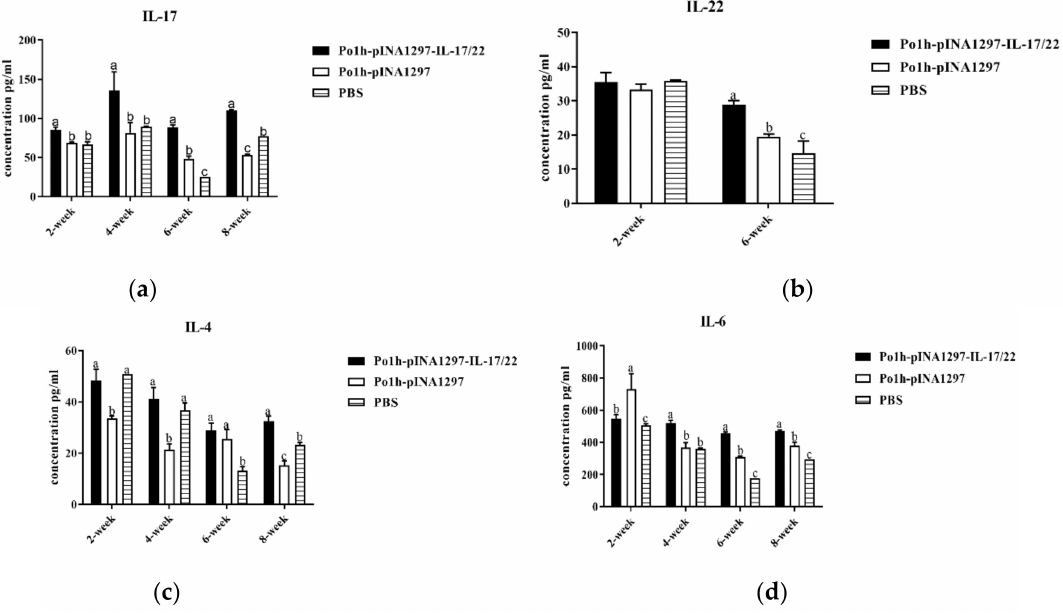
Figure 11. Change in IL-17 ( a ), IL-22 ( b ), IL-4 ( c ) and IL-6 ( d ) levels in the plasma of the piglets. The data with different lowercase letters are significantly different, p < 0.05. The IL-4 and IL-6 of the Po1h-pINA1297-IL-17/22 mice significantly increased com- pared to those of the PBS and Polh1297 mice from 14th to 56th days after inoculation (Figure 11c,d) ( p <